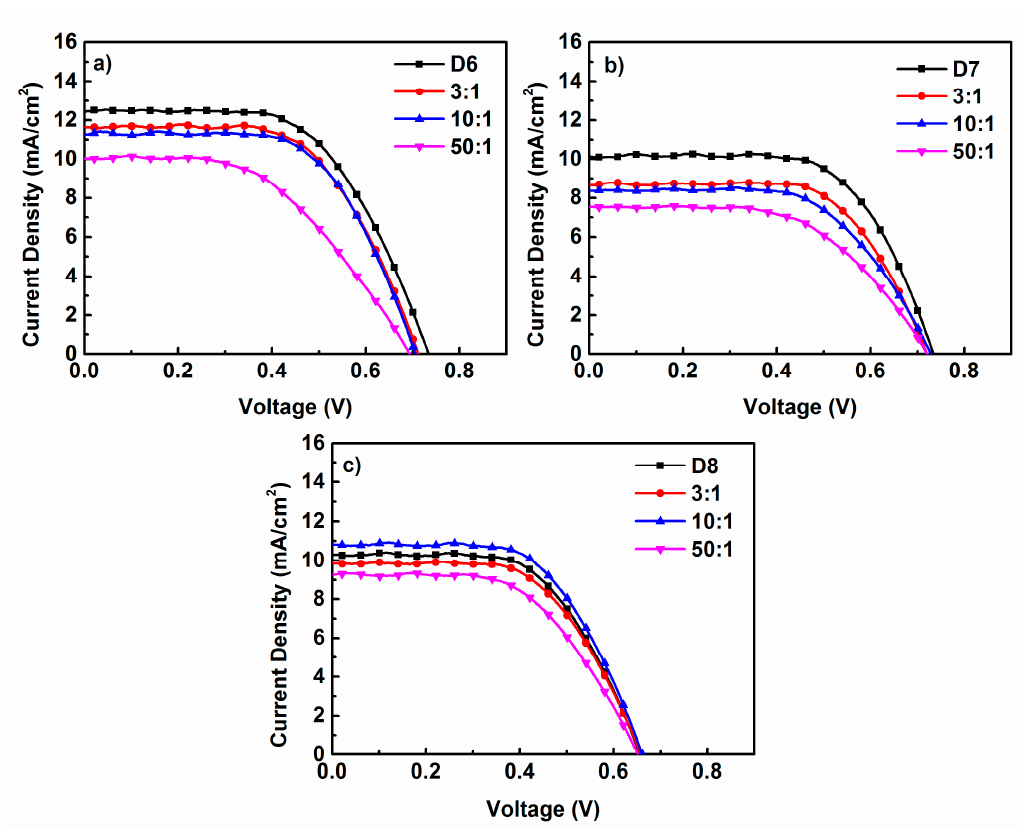
Figure 5. ( a ) J–V curves for the DSSCs based on dye D6 and co-sensitization of chenodeoxycholic acid (CDCA); ( b ) J–V curves for the DSSCs based on dye D7 and co-sensitization of CDCA; ( c ) J–V curves for the DSSCs based on dye D8 and co-sensitization of CDCA. Table 4. Photovoltaic parameters of DSSCs based on dyes D6 , D7 , D8 and N719 .